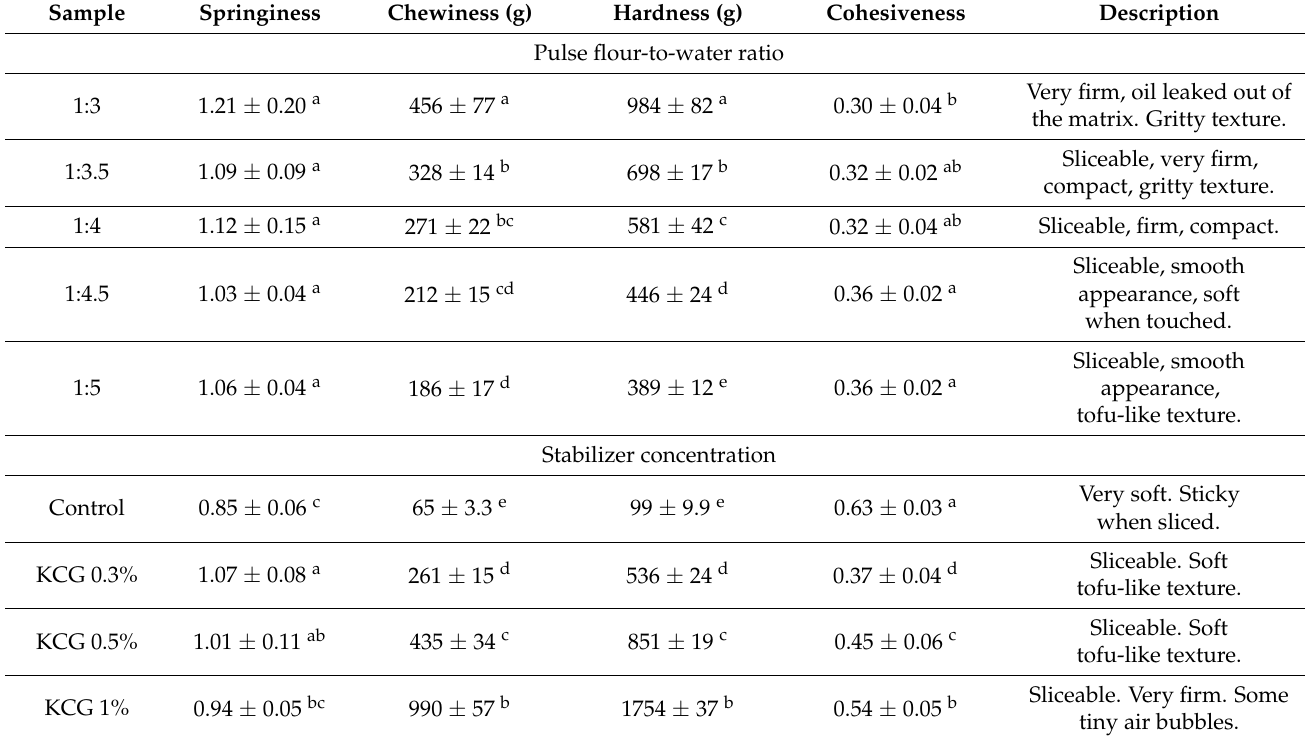
Table 2. The texture properties of pulse-based cheese analogues from yellow pea flour, showing the effects of the water ratio and stabilizer concentration 1 .